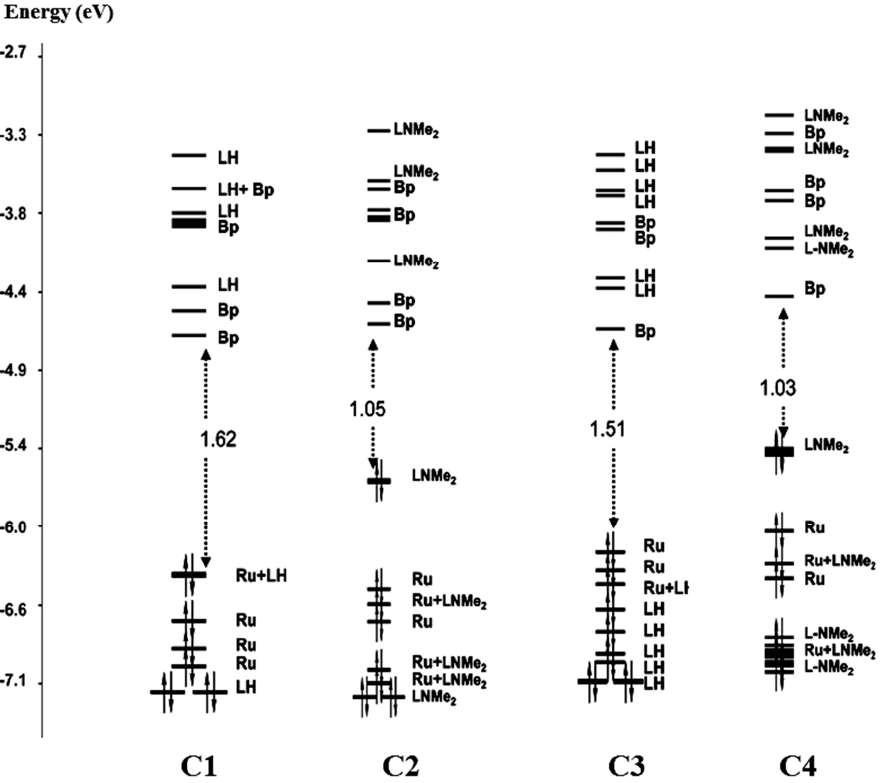
Figure 8. Molecular orbital energies and their composition in terms of basic fragments: Ru, LH, Bp and LNMe 2. The theoretical MO calculations show consistency with the electrochemical experimental results for the complexes (Table 1). It is noteworthy that a correlation coefficient of 0.95 was found when comparing the first electrochemical oxidation potential with the calculated energy of the HOMO orbital for the series of complexes under study. This relationship opens the possibility to employ theoretical information to gain insight on the trend of electrochemical experimental results. From the results in Figure 8 and Table 1, the assignment of the irreversible oxidation process to the amino group can be corroborated as complexes 2, 4 possess a HOMO orbital, related to the first oxidation, centered on the dimethylamino group. The same result is obtained by a fragment analysis performed for complexes C1 to C4, in an analogous way as described before for the free ligands. In C1, the first five occupied MO of higher energy contain d pure orbitals and mixture of d orbitals with orbitals from the chromophoric ligand. The HOMO energy varies between − 6 and − 6.5 eV, showing two nearly degenerated ligands, one centered on the metal (orbitals d) and the other a mixture of d orbitals with π orbital from the chromophoric ligand. The composition is similar for all the complexes with LH ligand independent of the substituent of the bipyridine ligand The first six unoccupied orbitals are dominated for the LUMO’s of the bipyridine ligands and the chromophoric ligand. Electronic density analysis shows that the LUMO is localized in the P fragment of the chromophoric ligand. Otherwise, the LUMO + 1 (0.11 eV higher in energy) is localized on the bipyridine ligand. In complexes 1 and 3, the